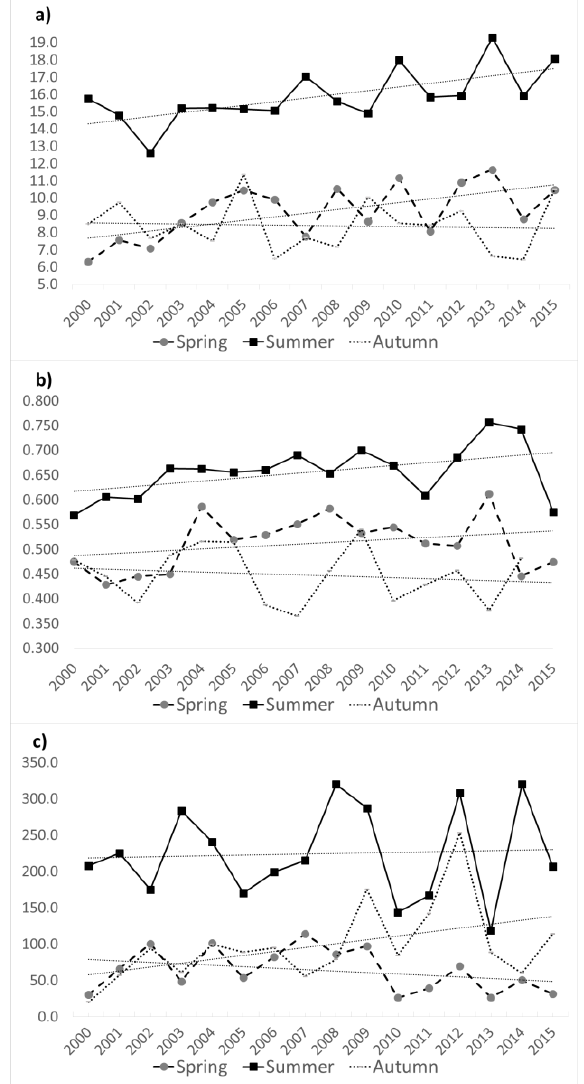
Figure 2. Trend graphs of the averaged surface air temperature (a), NDVI (b) and precipitation sums (c) for the 2000-2015 period. The trends produced for the Syktyvkar meteorological station data using allocation of the growing season frames based on the surface air temperature observation at the